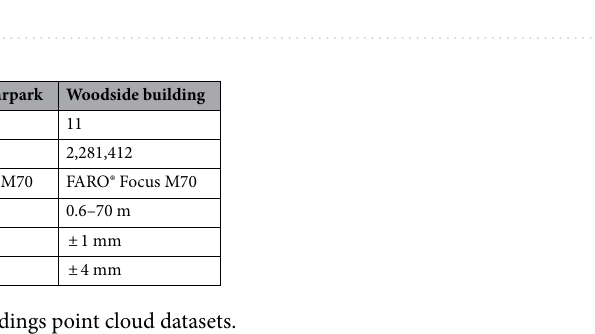
Figure 6. The workflow for the geometric digital twin-driven dimensional quality inspection of building structural members.